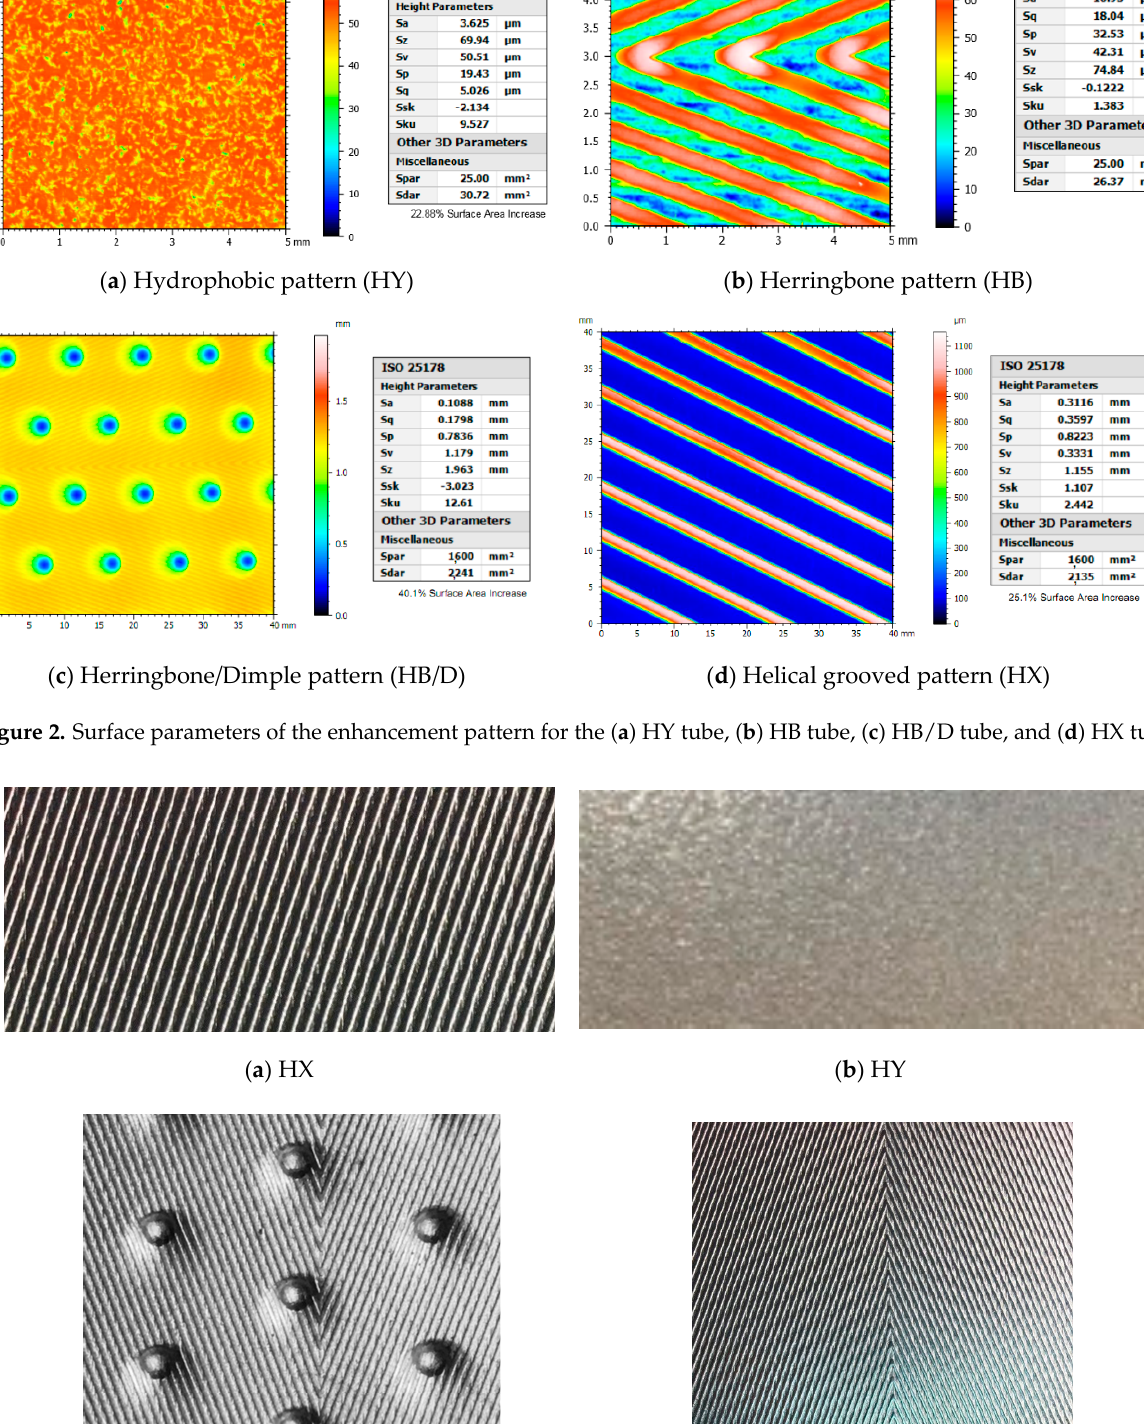
Figure 3. Photographs of the external surfaces of the heat transfer tubes that were evaluated: ( a ) HX; ( b ) HY; ( c ) HB/D; ( d ) HB.